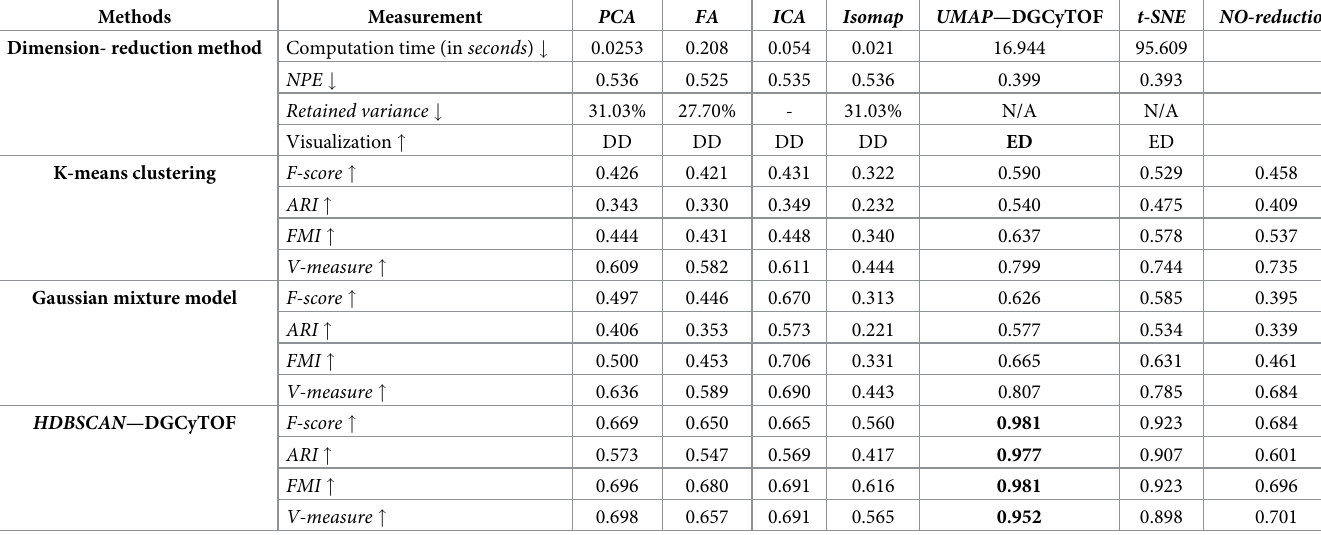
Table 5. Comparison of machine-learning methods by different measurements for CyTOF Dataset 2 (32 biomarkers, 14 labeled cell